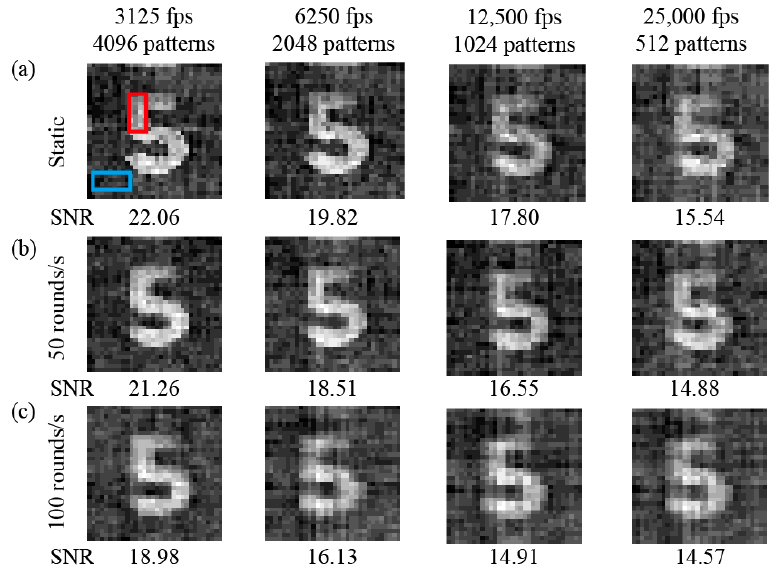
Figure 5. The reconstructed images using the LED-based computational ghost imaging system. ( a ) Reconstructed images of the static object with different compression rates; ( b ) reconstructed images of the rotating object at 50 rounds/s; ( c ) reconstructed images of the rotating object at 100 rounds/s.